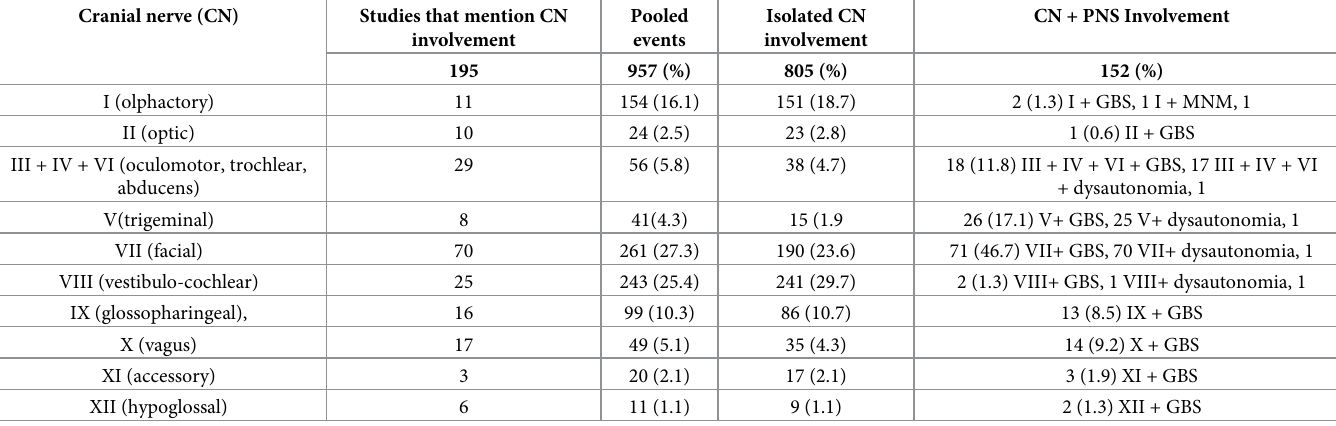
Table 2. Types of cranial nerves involvement in patients with